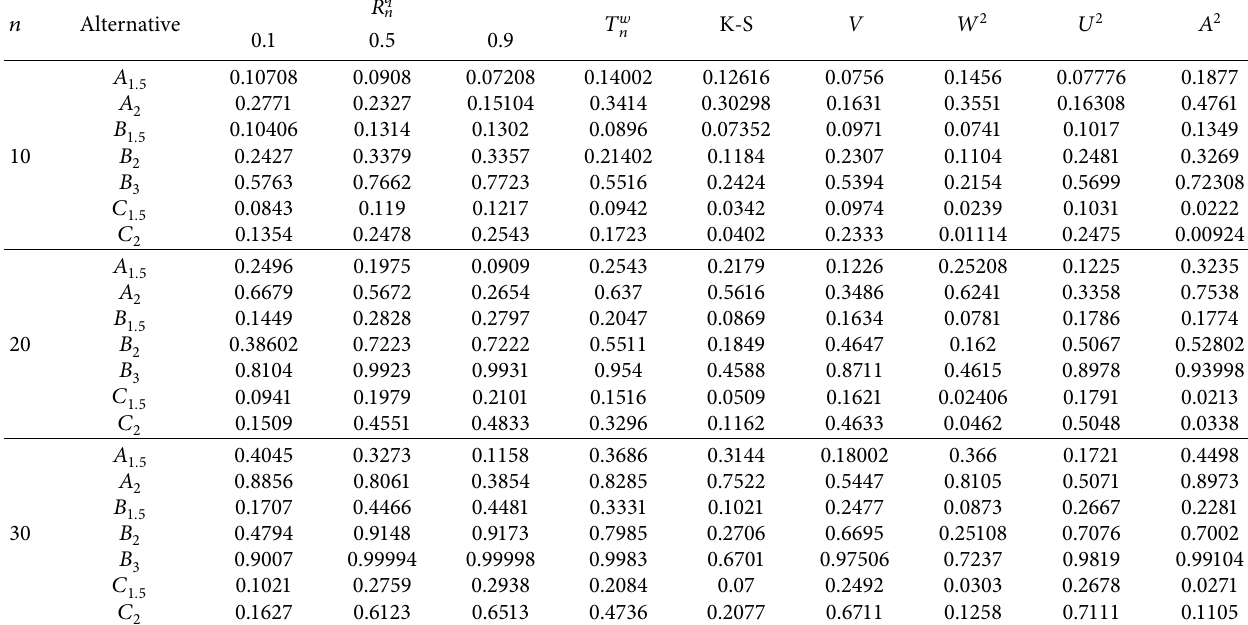
Table 2: Power estimates of the tests at level α � 0 .